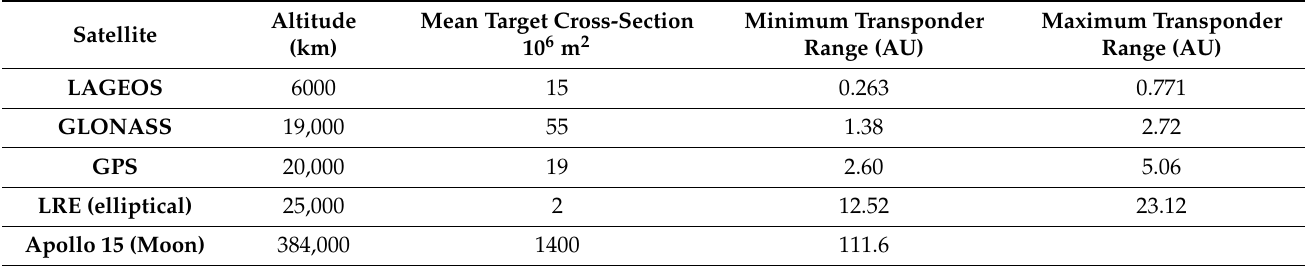
Table 2. Satellites currently tracked by the International Laser Ranging Service (ILRS) that can mimic interplanetary links in the testing of laser transponders and communications. Because the satellite returns are only visible within a certain range of the source of the laser radiation, the Earth and planetary terminals must be collocated during the planetary